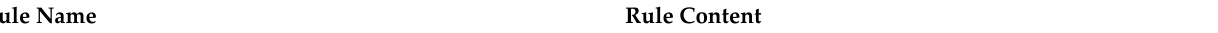
Table 6. Renewal rules for expressways with slip resistance loss/pavement wear and severe traffic